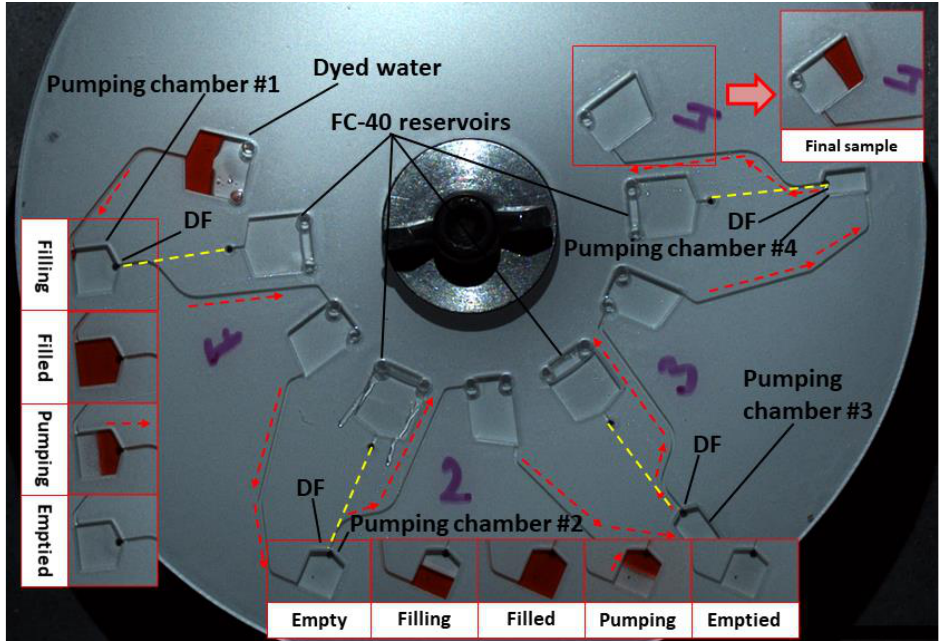
Figure 3. Monte Carlo simulation (99,999 runs) for the distribution of (aqueous) sample from a chamber in an injection-moulded part. The chamber has a nominal volume of 80 μL (dimensions 12.5 mm long, 8 mm wide, and 1 mm deep) and the model assumes manufacturing of an 8 μm systematic thermal shrinkage and a 2 µm tolerance in thickness.